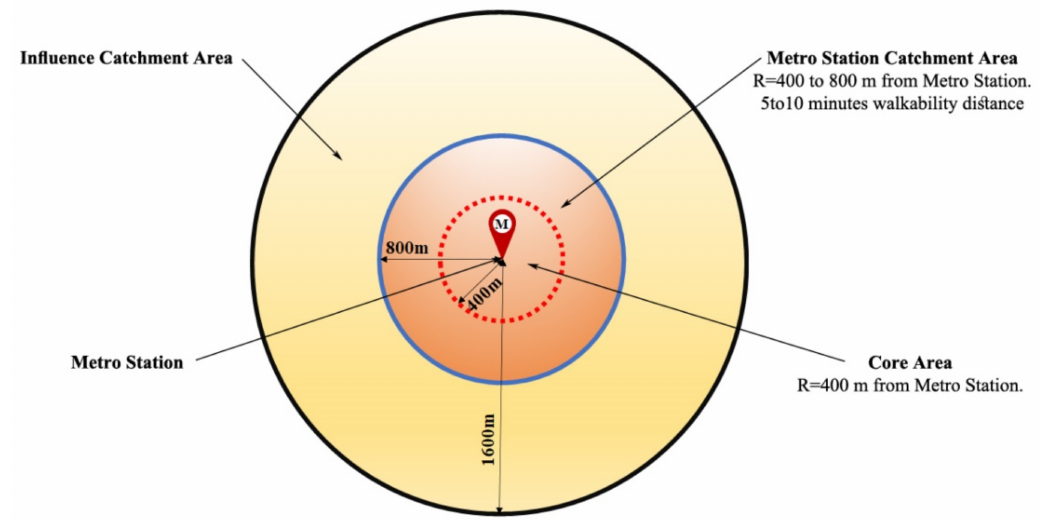
Figure 1. The elements of the metro station Dependent Component Area